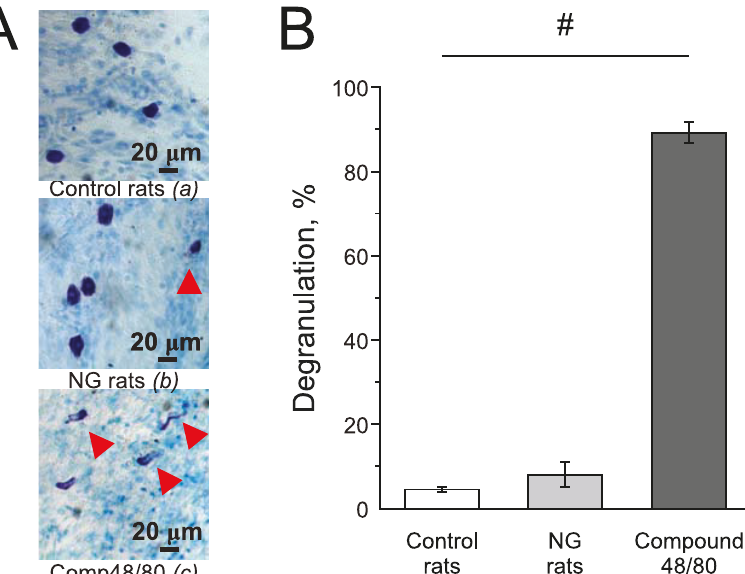
Figure 7. Effect of chronic nitroglycerine administration on mast cell degranulation in rat meninges. ( A ) Toluidine Blue staining of the meninges in the control ( a ) ( n = 5); in the NG-induced migraine model group (NG rats; n = 4); ( b ); after exposure to Compound 48/80 in the control (10 mg/mL; 30 min; n = 4) ( c ). Notice red arrows indicating degranulated mast cells. ( B ) Histograms showing the percent of degranulated mast cells in the control group, model group, and after Compound 48/80. Mean ± SEM. # p <